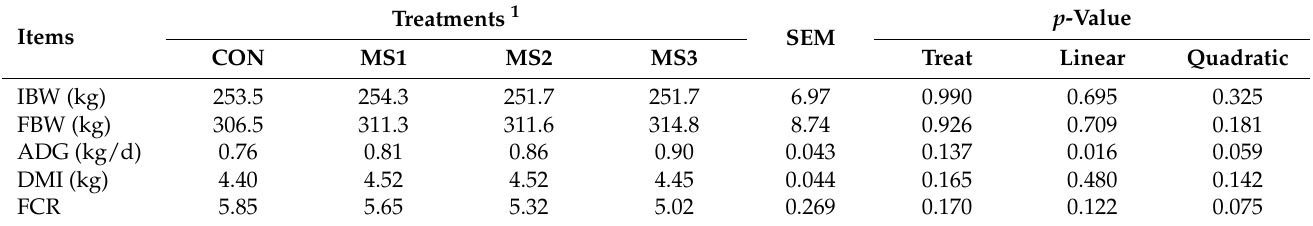
Table 2. Effect of MetaSmart supplementation in diets on growth performance and economic benefit of